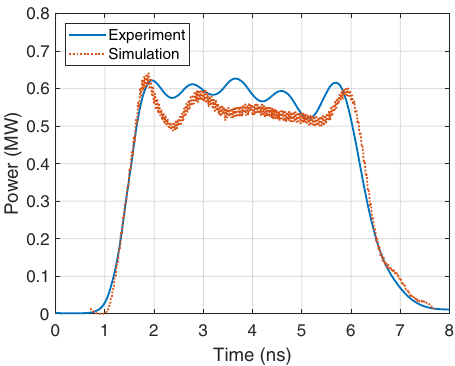
FIG. 20. FFTof the rf pulse in Fig. 19 from an eight bunch train with total charge of 12 nC bunch, along with accompanying PIC simulation